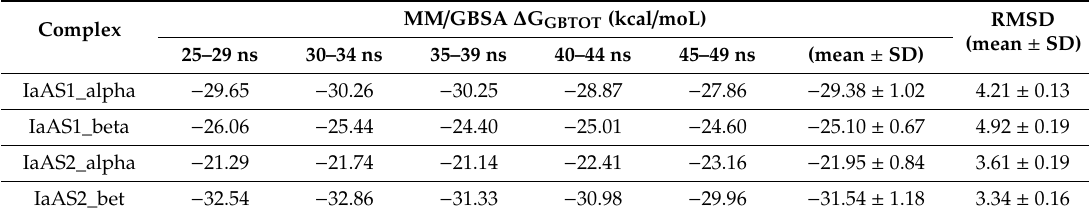
Table 2. Predicted binding free energy by molecular dynamics (MD)